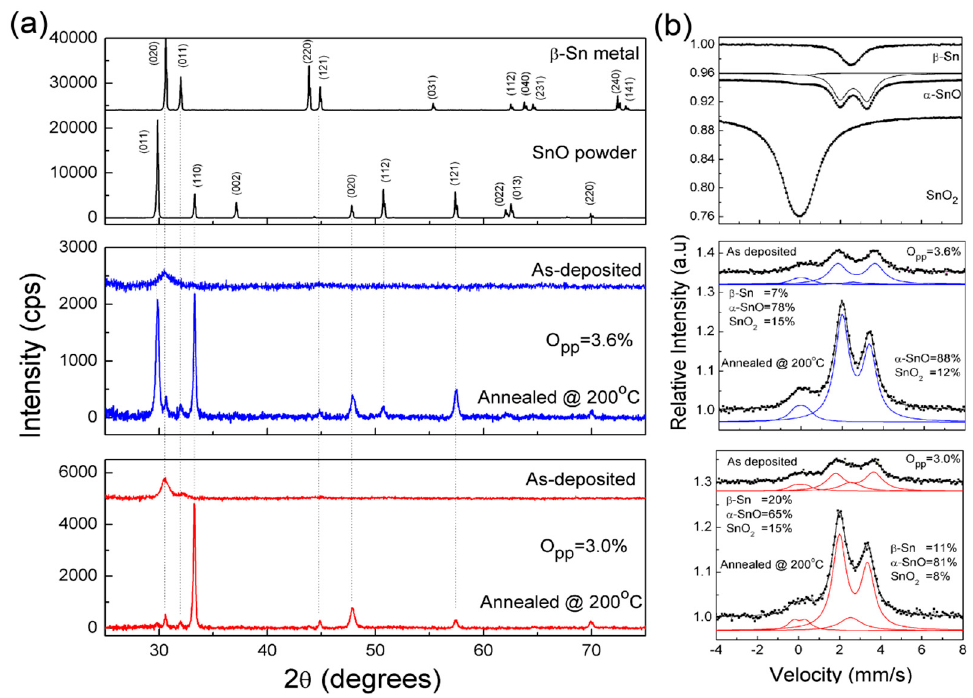
Figure 1. ( a ) Diffractograms of SnO x thin films as-deposited. ( b ) Transmission 119 Sn Mössbauer and CEMS spectra of as-deposited and annealed SnO x films with O pp = 3.0% and O pp = 3.6% O pp , respectively.